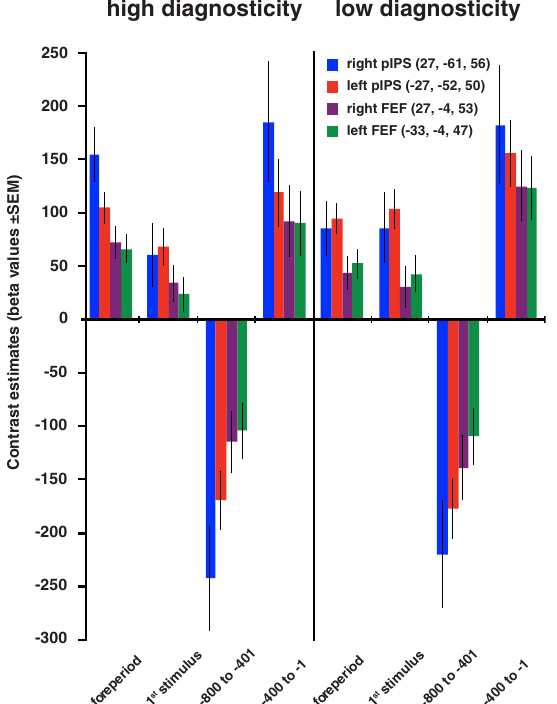
Figure 3. Experiment 1 contrast estimates in the frontoparietal attentional network in time periods * during tasks * 400 ms epochs Abbreviations: FEF, frontal eye field; pIPS, posterior intraparietal sulcus; SEM, standard error of the mean. Foreperiod refers to task signaling in the beginning of the